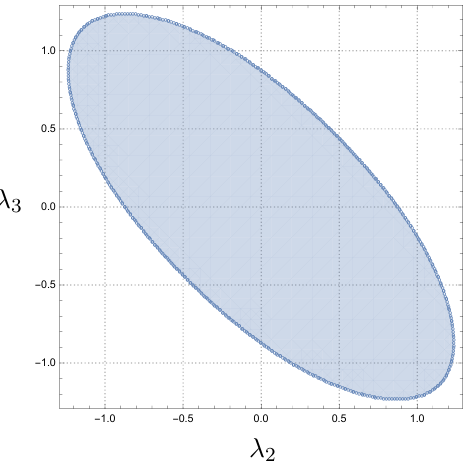
Figure 8 . Holographic RG flow from N = 4 SYM 4 (UV) to N = 4 J-fold CFT 3 (IR) with Λ = − 1 and ( λ ) = ( − 0 . 8 , 0 , 0) . 1 , λ 2 , λ 3